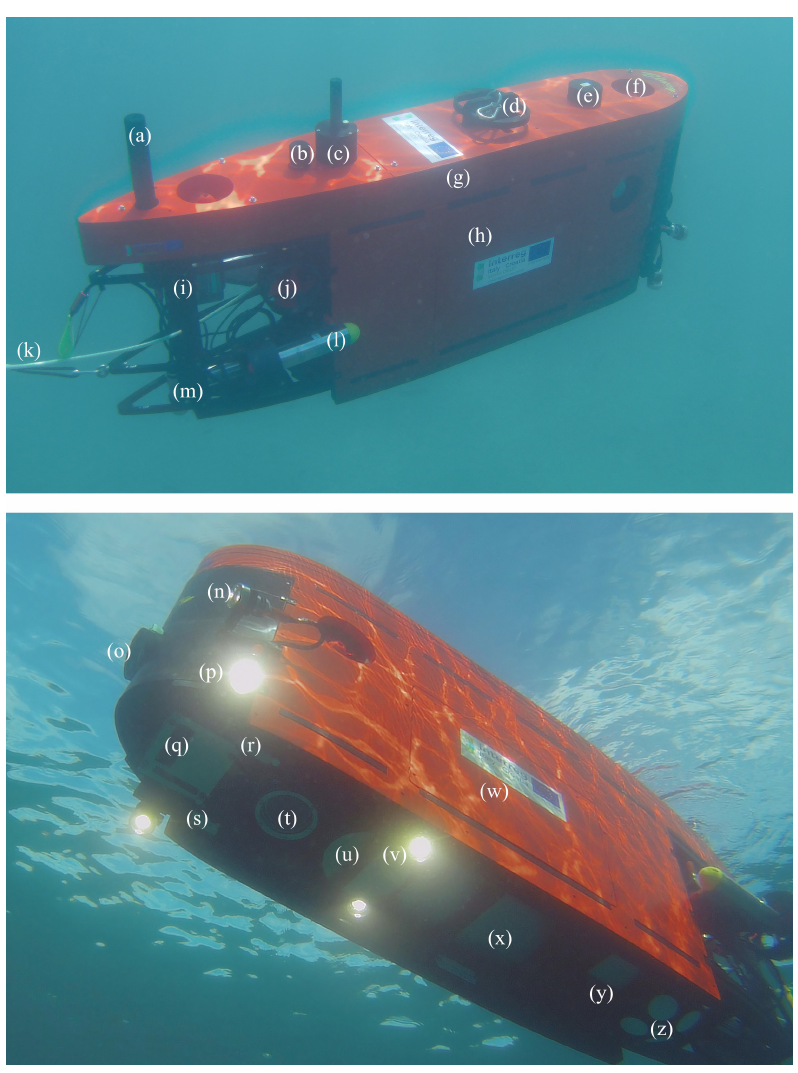
Figure 8. Main prototype UUV components: ( a ) Wi-Fi communication. ( b ) USBL transponder. ( c ) Ra- dio communication. ( d ) Hook. ( e ) AHRS: GNSS and INS. ( f ) Thruster: vertical. ( g ) Main buoyancy foam. ( h ) Lateral buoyancy foam panel. ( i ) HDPE structure. ( j ) Thruster: lateral. ( k ) Fiber optic cable. ( l ) Thruster: longitudinal. ( m ) Altimeter. ( n ) Frontal LED lights. ( o ) PilotCAM. ( p ) Adjustable LED lights. ( q ) MBES sonar head. ( r ) MiniSVS. ( s ) MiniCT. ( t ) BottomCAM. ( u ) MBES computer. ( v ) Bottom LED lights. ( w ) Navigation, Guidance and Control (NGC) computer. ( x ) UUV 24V Battery. ( y ) FOG. ( z )